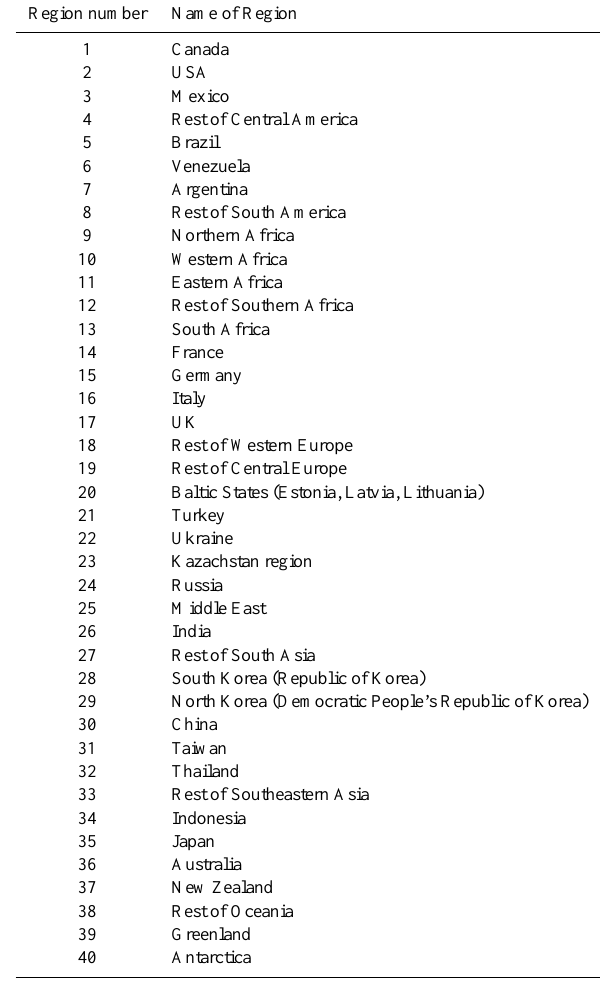
Table 2. List of